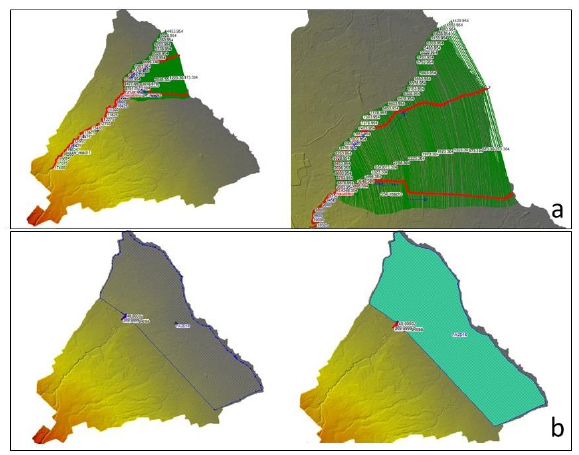
Figure 9. Comparison between the 1D (a) and 2D (b) methods